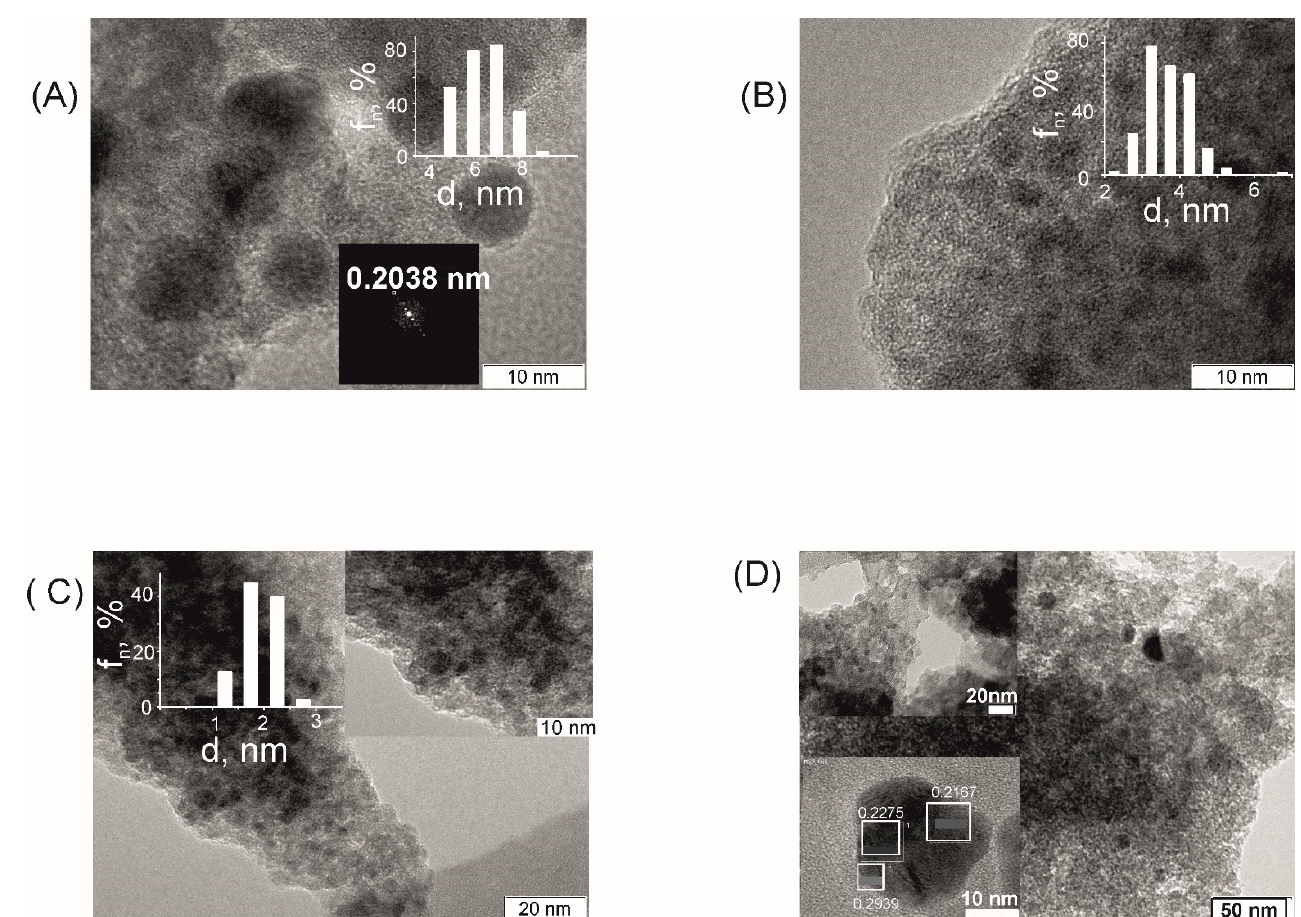
Figure 1. TEM micrographs and histograms of the particle size distribution (inserted) of the pow- dered catalysts ( A ) PdZn/TiO 2 -H-573, ( B ) PdZn/Ti 0.8 Zr 0.2 O 2 -H-573, ( C ) PdZn/Ti 0.95 Ce 0.05 O 2 H-773, ( D ) PdZn/Ti 0.8 Zn 0.2 O 1.8 -H-573. The white square indicates the size of diffraction area.